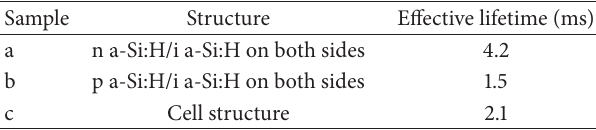
Table 1: Effective lifetime ( 𝜏 ) of samples with various structures eff measured by SINTON lifetime tester in the transient mode at minority carrier density of 2 × 10 15 cm − 3